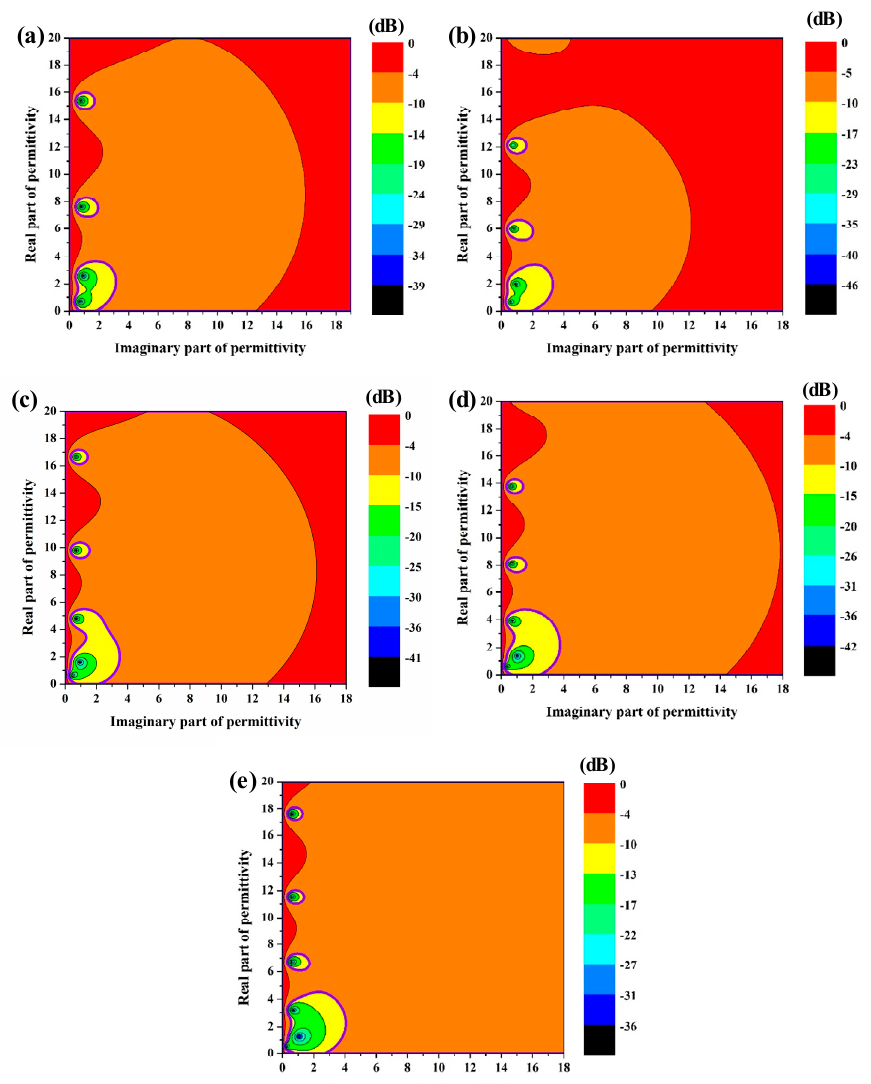
Figure 2. Reflection loss spectrums of a honeycomb core 15 mm in height with different equivalent dielectric properties: ( a ) 8.2 GHz, ( b ) 9.2 GHz, ( c ) 10.2 GHz, ( d ) 11.2 GHz, and ( e ) 12.2 GHz.